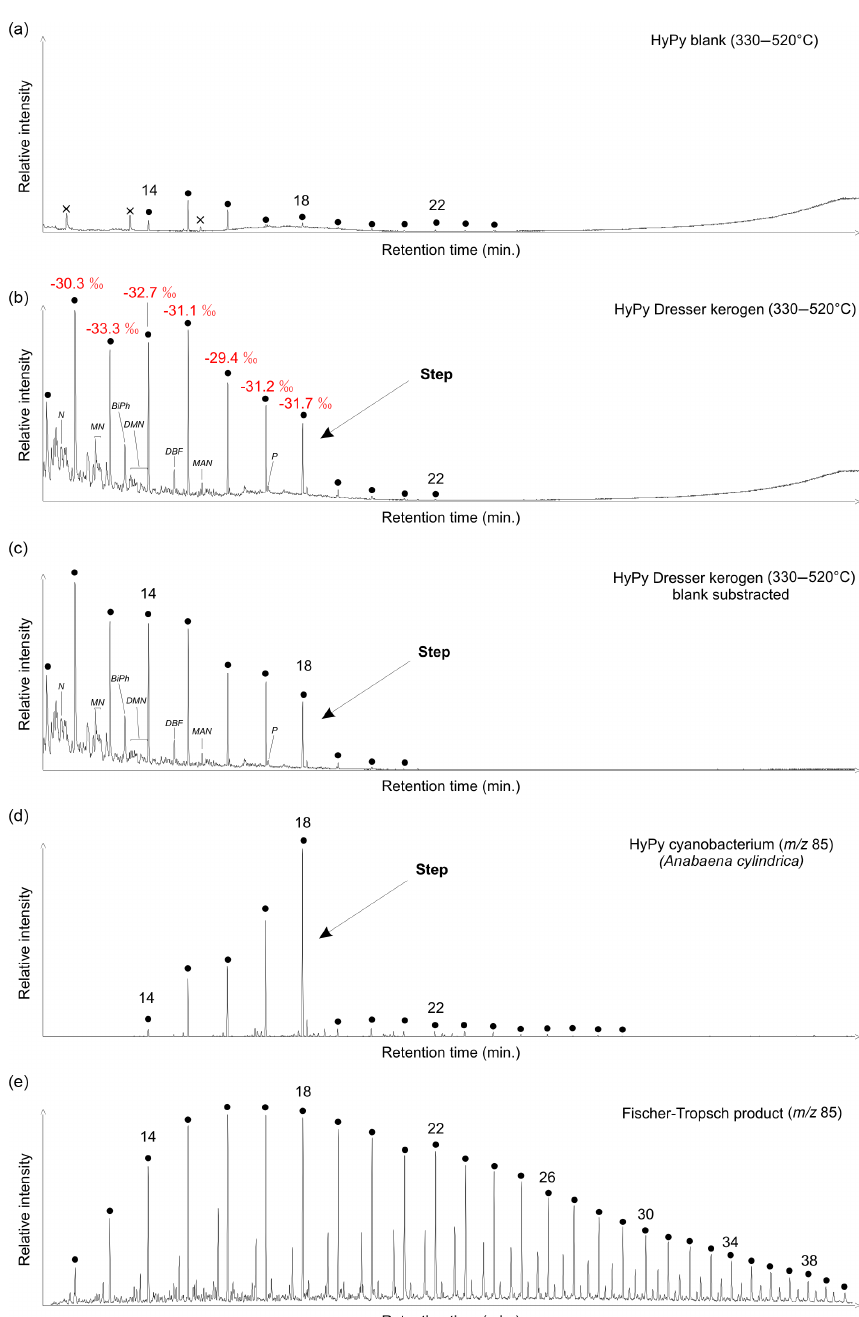
Figure 3. Total ion currents ( a–c ; on the same scale) and ion chromatograms selective for alkanes ( d–e ; m/z 85). (a) High-temperature HyPy (330–520 ◦ C) product of analytical blank (combusted sea sand) obtained prior to HyPy of the Dresser kerogen. n -Alkanes in the range of n -C 14 to n -C 24 (maxima at n -C 15 ) represent HyPy background contamination. (b) High-temperature HyPy (330–520 ◦ C) product of the Dresser kerogen. Note the sharp decrease in abundance of n -alkanes beyond n -C 18 (see arrows). δ 13 C values of n -C 12 to n -C 28 show a high similarity to the δ 13 C TOC value ( − 32.8 ± 0.3‰), further confirming syngeneity. (c) Blank subtraction ( b minus a ) showing that contaminants have no major impact on the n -alkane pattern yielded during the high-temperature HyPy step of the Dresser kerogen (b) . (d) HyPy products of cell material of the heterocystous cyanobacterium Anabaena cylindrica . Note the sharp decrease in abundance of n -alkanes beyond n -C 18 (see arrows), similar to the n -alkane distribution of the Dresser kerogen (b) . (e) Products of experimental Fischer– Tropsch-type synthesis under hydrothermal conditions; abiogenic n -alkanes show a unimodal distribution that is distinctly different from the Dresser kerogen. Black dots: n -alkanes (numbers refer to carbon chain lengths); N: naphthalene; MN: methylnaphthalenes; BiPh: 1,1 (cid:48) - biphenyl; DMN: dimethylnaphthalenes; DBF: dibenzofuran; MAN: methylacenaphthene; P: phenanthrene; crosses: siloxanes (GC column or septum